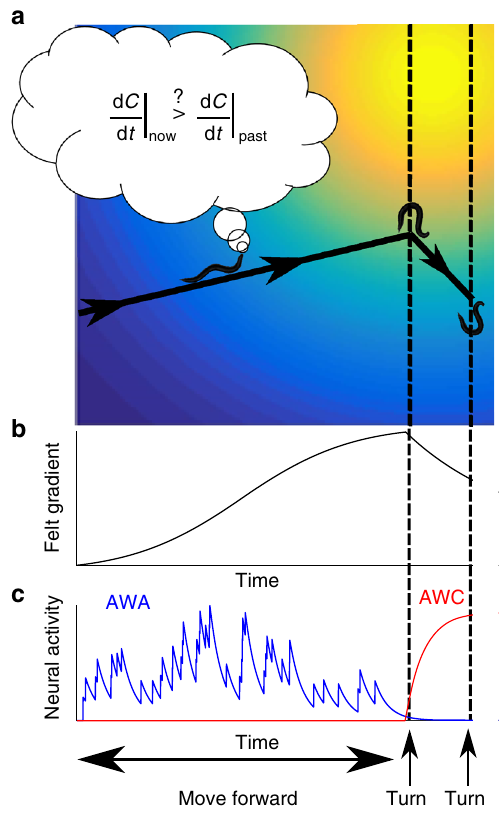
Fig. 6 A mechanistic view of the neural codes for the ef fi cient navigation strategy. a A trajectory of a navigating animal in a Gaussian spatial gradient of an attractant. Dashed lines mark turning events. b The temporal gradient sensed by the navigating worm in search for the attractant source. c AWA and AWC dynamics in response to the sensed gradient. AWA stochastic pulsatile activity controls the worm forward movement. AWA adapts to the fi rst derivative of the gradient, so when the gradient begins to fl atten (and although the fi rst derivative is still positive), AWA activity decays, thereby promoting a turn. In case the turn steers the worm away from the target, the negative gradient is immediately sensed by the AWC neuron, which responds robustly and deterministically to promote a second turn. Thus, the orchestrated activity of AWA and AWC underlies the ef fi cient